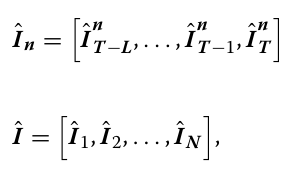
Using AI model to predict time series